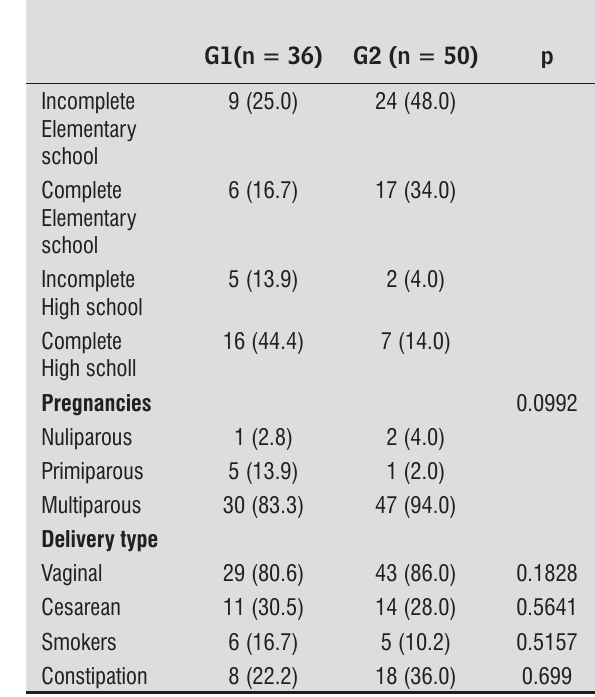
Table 1 - Sociodemographic, clinical and obstetrical data background of (G1) women on reproduc- tive age and on (G2) postmenopausal period